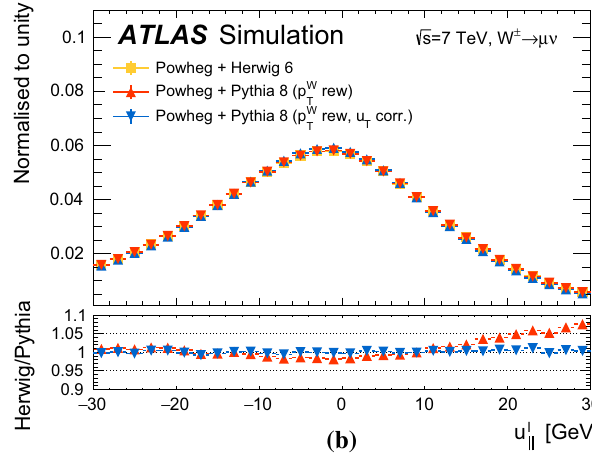
distribution in Powheg+Pythia 8 is reweighted to text. The p W T the Powheg+Herwig 6 prediction. The lower panels show the ratios of Powheg+Herwig 6 to Powheg+Pythia 8 , with and without the response correction in the Powheg+Pythia 8